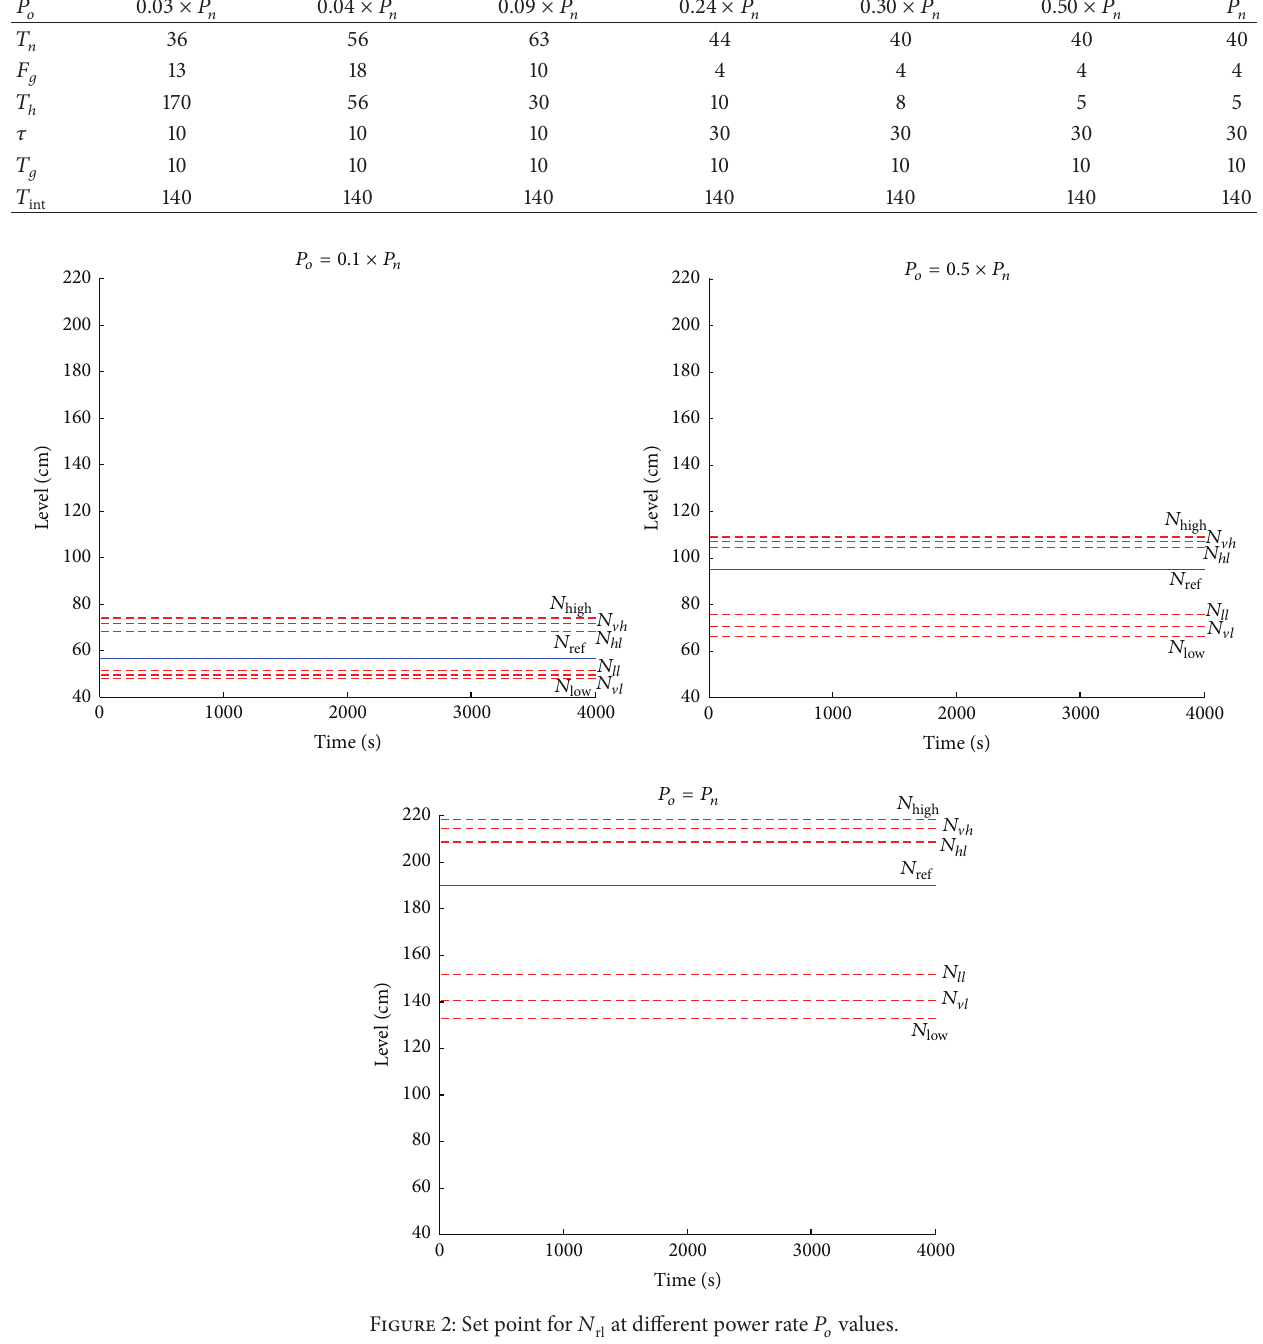
at different power rate 𝑃 𝑜 rl